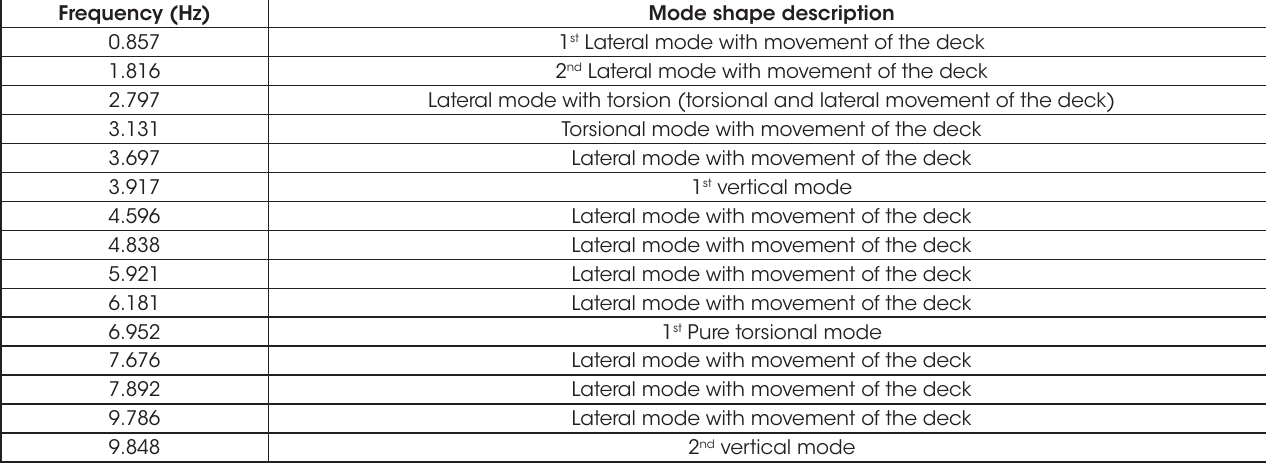
Frequencies and mode shapes description obtained for the model in which the deck was modeled as mass. (Brasiliano et al. [9])